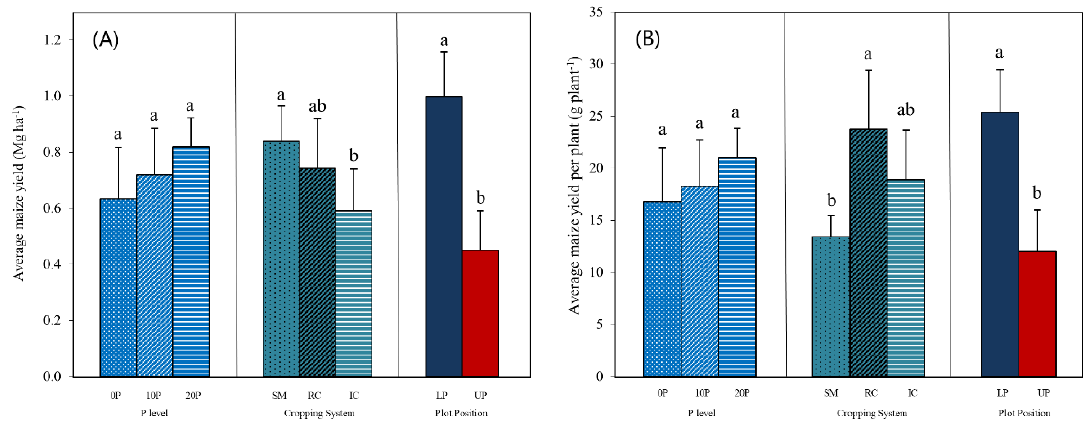
Figure 5. ( A ) Average maize yield and ( B ) average maize yield per plant of all treatments of the researcher-managed field trial. 0P, 10P and 20P represent addition of 0, 10 and 20 kg P ha -1 , respectively. SM, RC and IC represent sole maize, relay cropping and intercropping, respectively. LP and UP represent lower plot and upper plot, respectively. Values presented are means with standard error bars (N = 6 for P level and cropping system, N = 4 for plot position). Small letters indicate significant difference between different levels within the studied variables ( p < 0.05); statistical tests were not performed across variables.